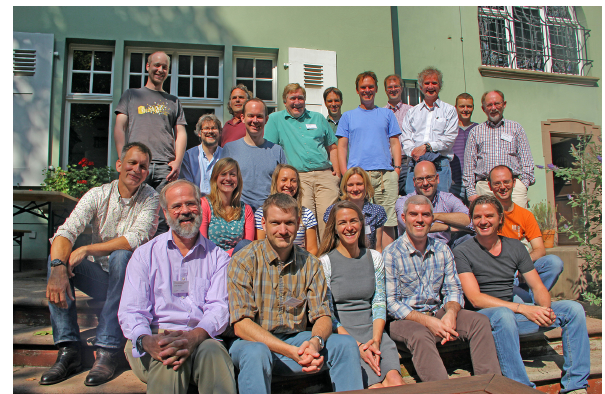
Figure 3. Group photo of workshop participants in front of the IWH venue. Photo: Lucas